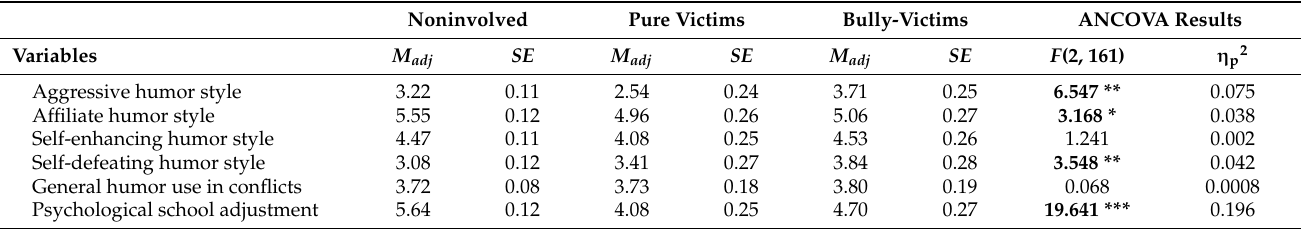
Table 4. ANCOVA results: Marginal means and standard errors in bullying-related role groups regarding humor-related variables and psychological adjustment in